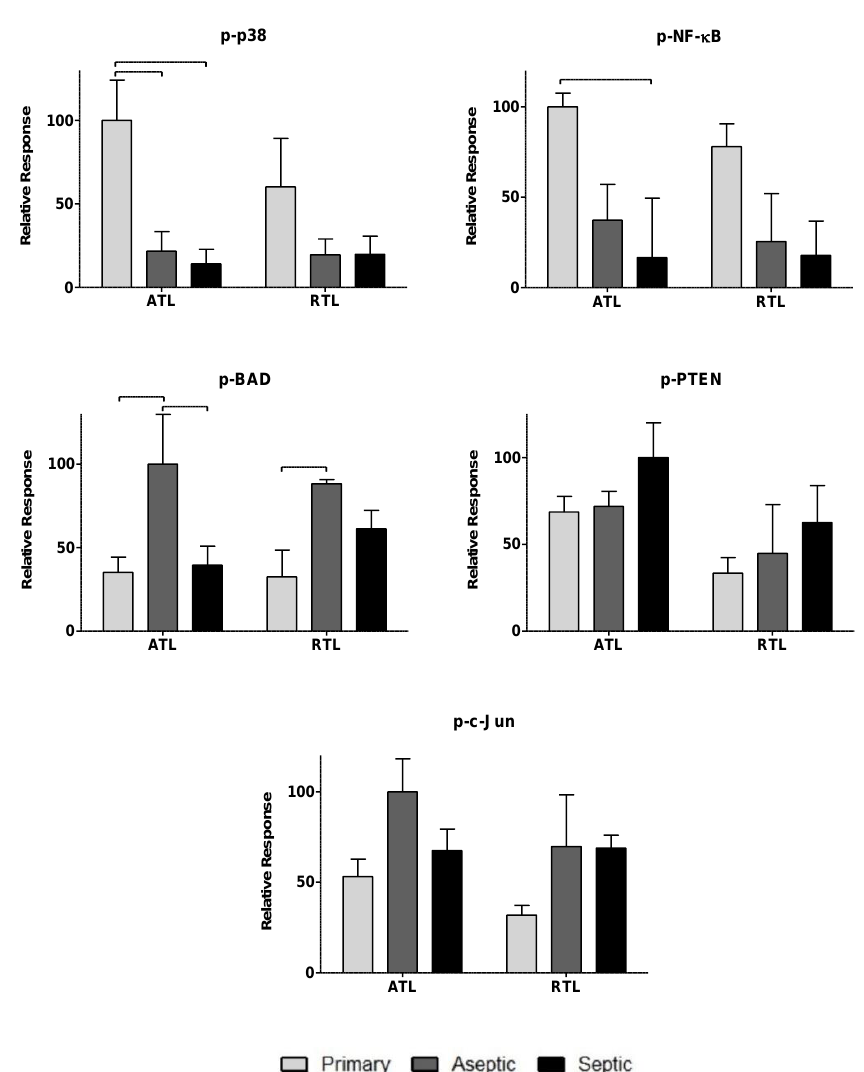
Figure 5. Relative levels of pro-apoptotic and inhibitory wound healing phosphoproteins in acute wound healing. Relative phosphoprotein responses (normalized to highest signal) were observed for all three patient groups: primary, aseptic, and septic at two debridement depths: ATL is closer to the knee joint, and RTL is approximately 1 cm removed from the knee joint. Statistically significant differences ( p < 0.05) were determined by two-way ANOVA with Bonferroni’s post-test to examine group-dependent and spatially-dependent differences in protein phosphorylation. Differences for the same group (i.e., septic) between ATL and RTL are marked with an asterisk (*). Differences between groups within a tissue layer are denoted with bars. Responses are shown as the mean ± SEM.